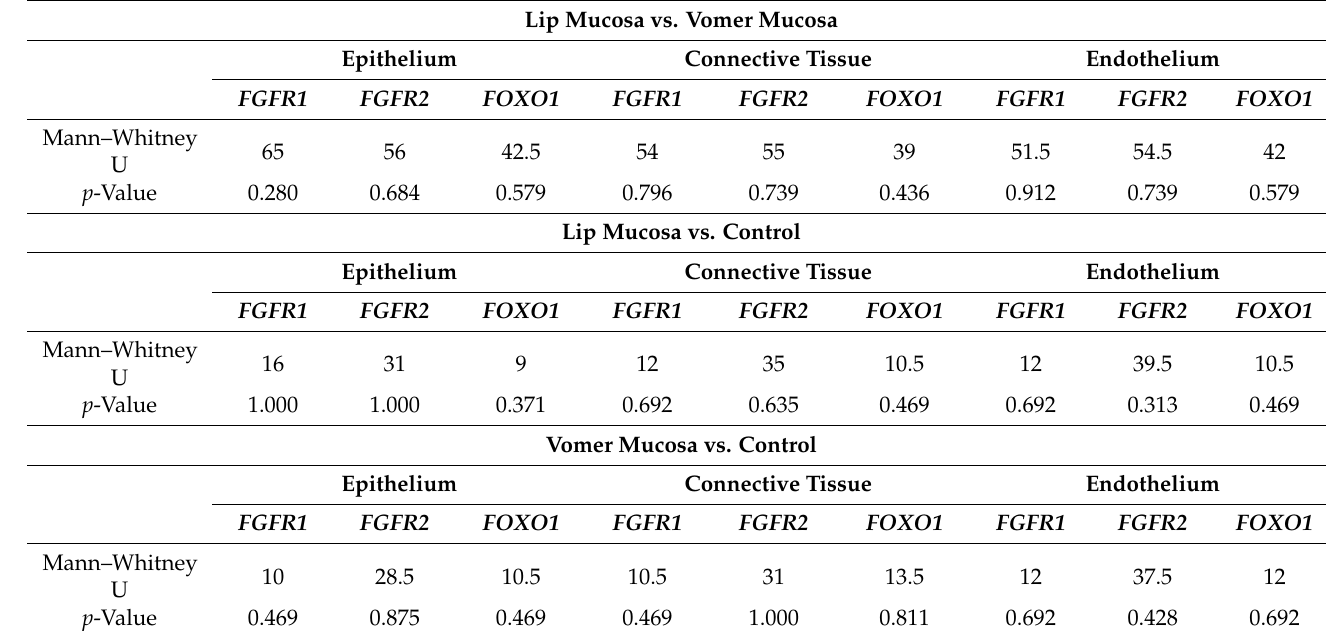
Table 3. The statistical importance of the distribution of FGFR1 , FGFR2 and FOXO1 genes between the patients’ lip and palatine mucosa as well as the control group and study group.